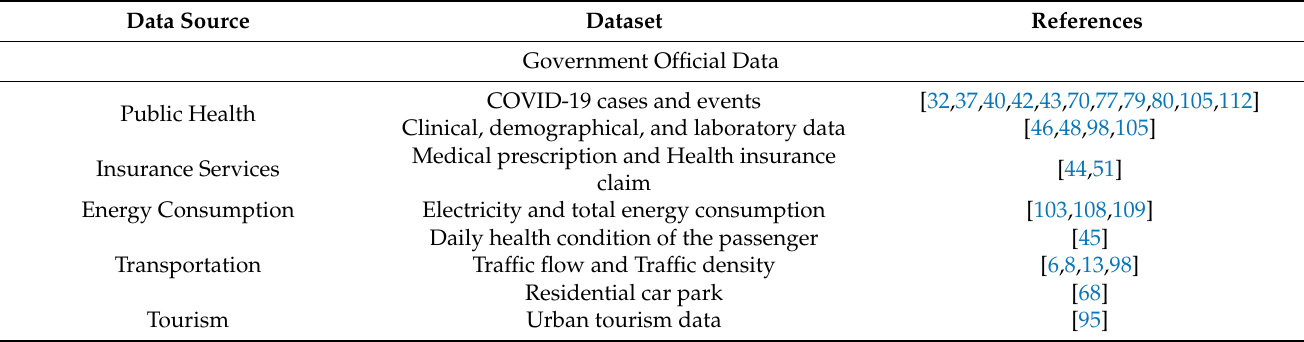
Table 3. Data source and